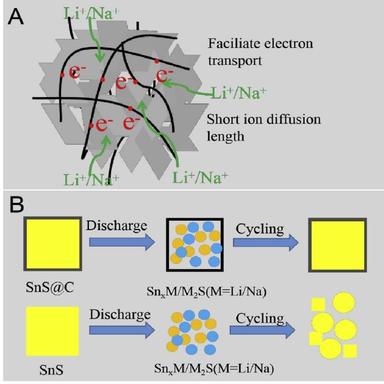
(A) The pathways of Liþ/Naþ and electrons are displayed for the SnS/CNT@C composite; (B) Schematic illustration of the morphology evolutions of SnS@C and SnS during cycling.